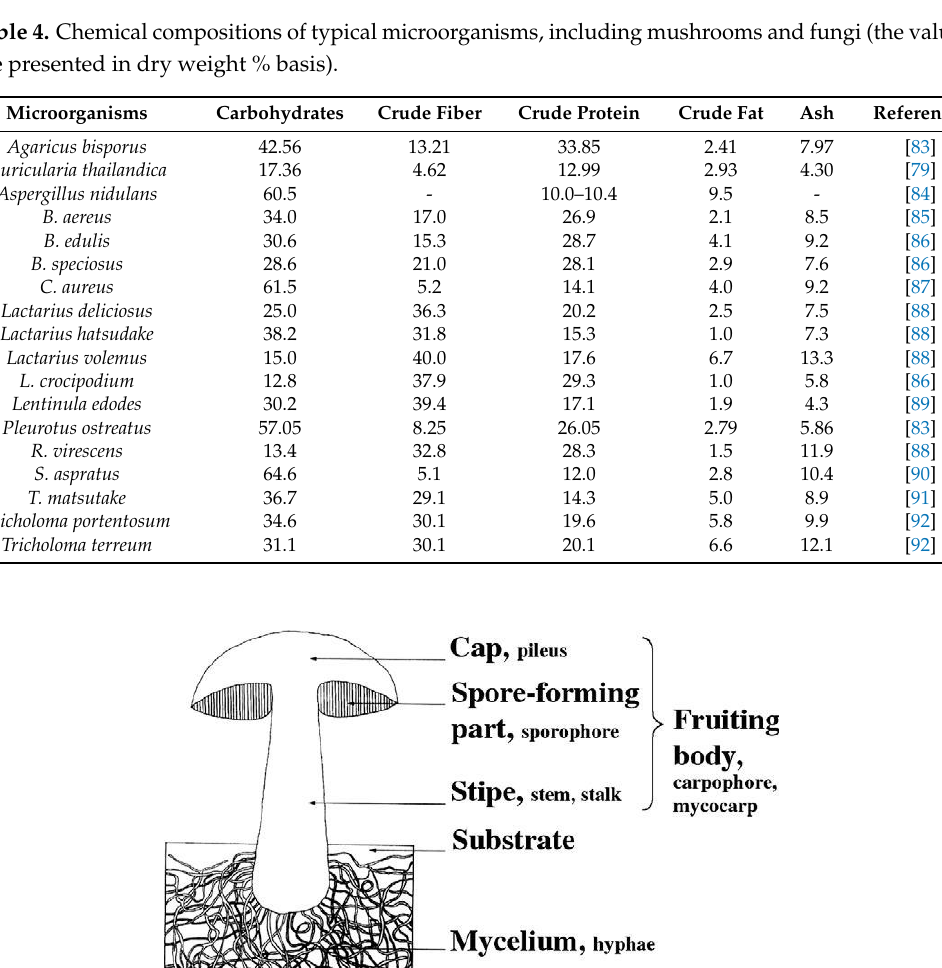
Table 4. Chemical compositions of typical microorganisms, including mushrooms and fungi (the values are presented in dry weight % basis).